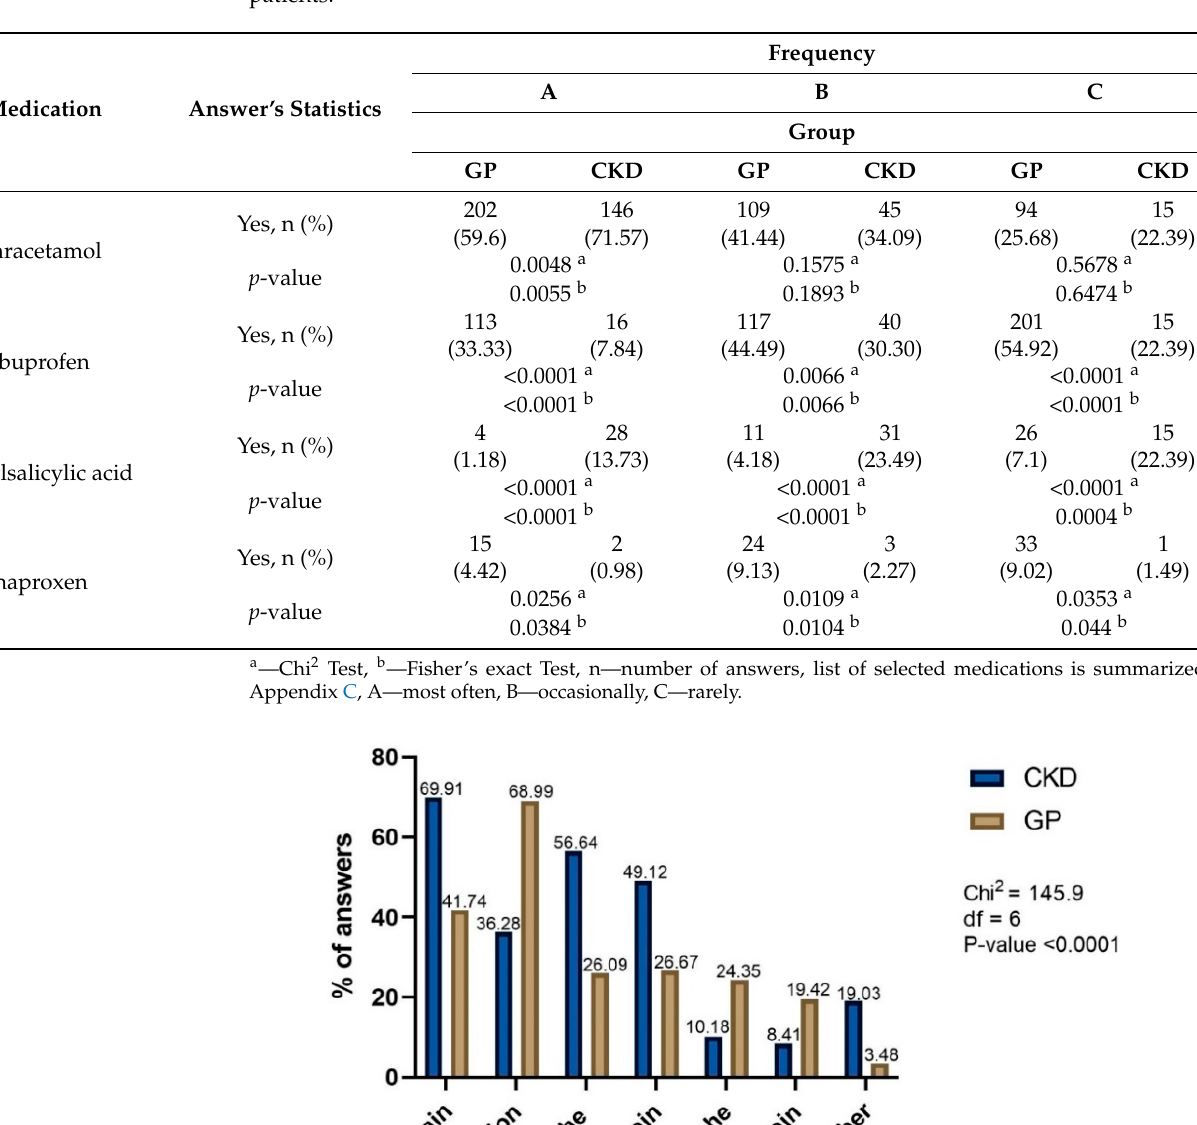
Table 6. The association of gender with type of the most frequently used NSAIDs or analgesics.